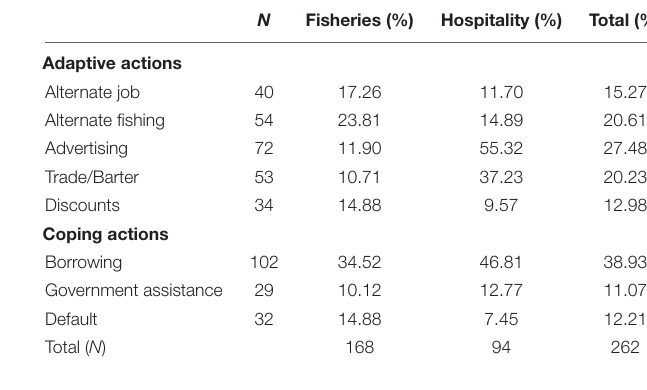
TABLE 4 | Adaptive and coping actions taken in response to the 2015 HAB event by employment